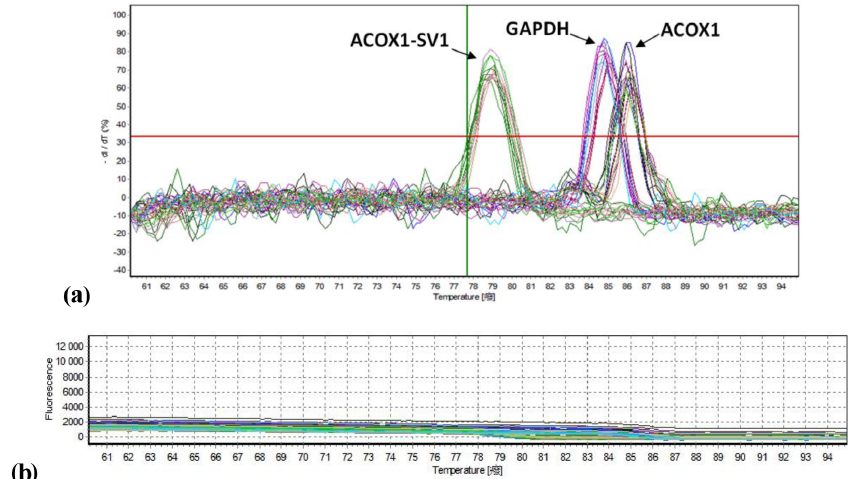
Figure 6. Melt peak (a) and melt curve (b) chart of ACOX1, ACOX1-SV1 and the reference gene GAPDH for RT-qPCR.